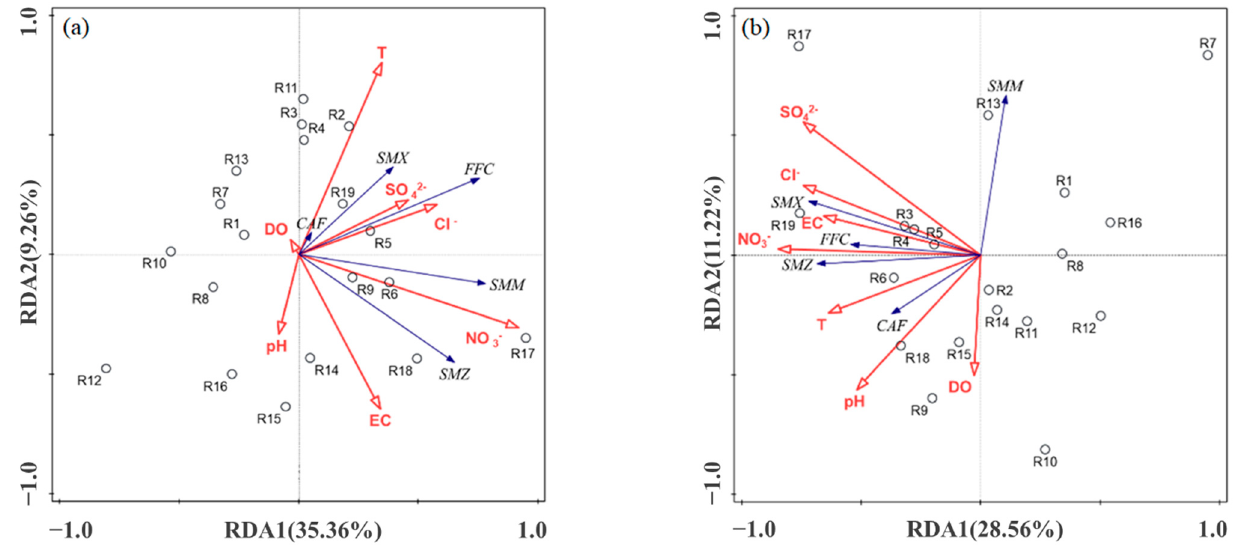
Figure 5. Redundancy analysis results showing the relationships between PPCPs (blue arrows) and environmental factors (red arrows) in the Lianjiang River in the wet season ( a ) and the dry season ( b ), the empty circles represent the sampling points.